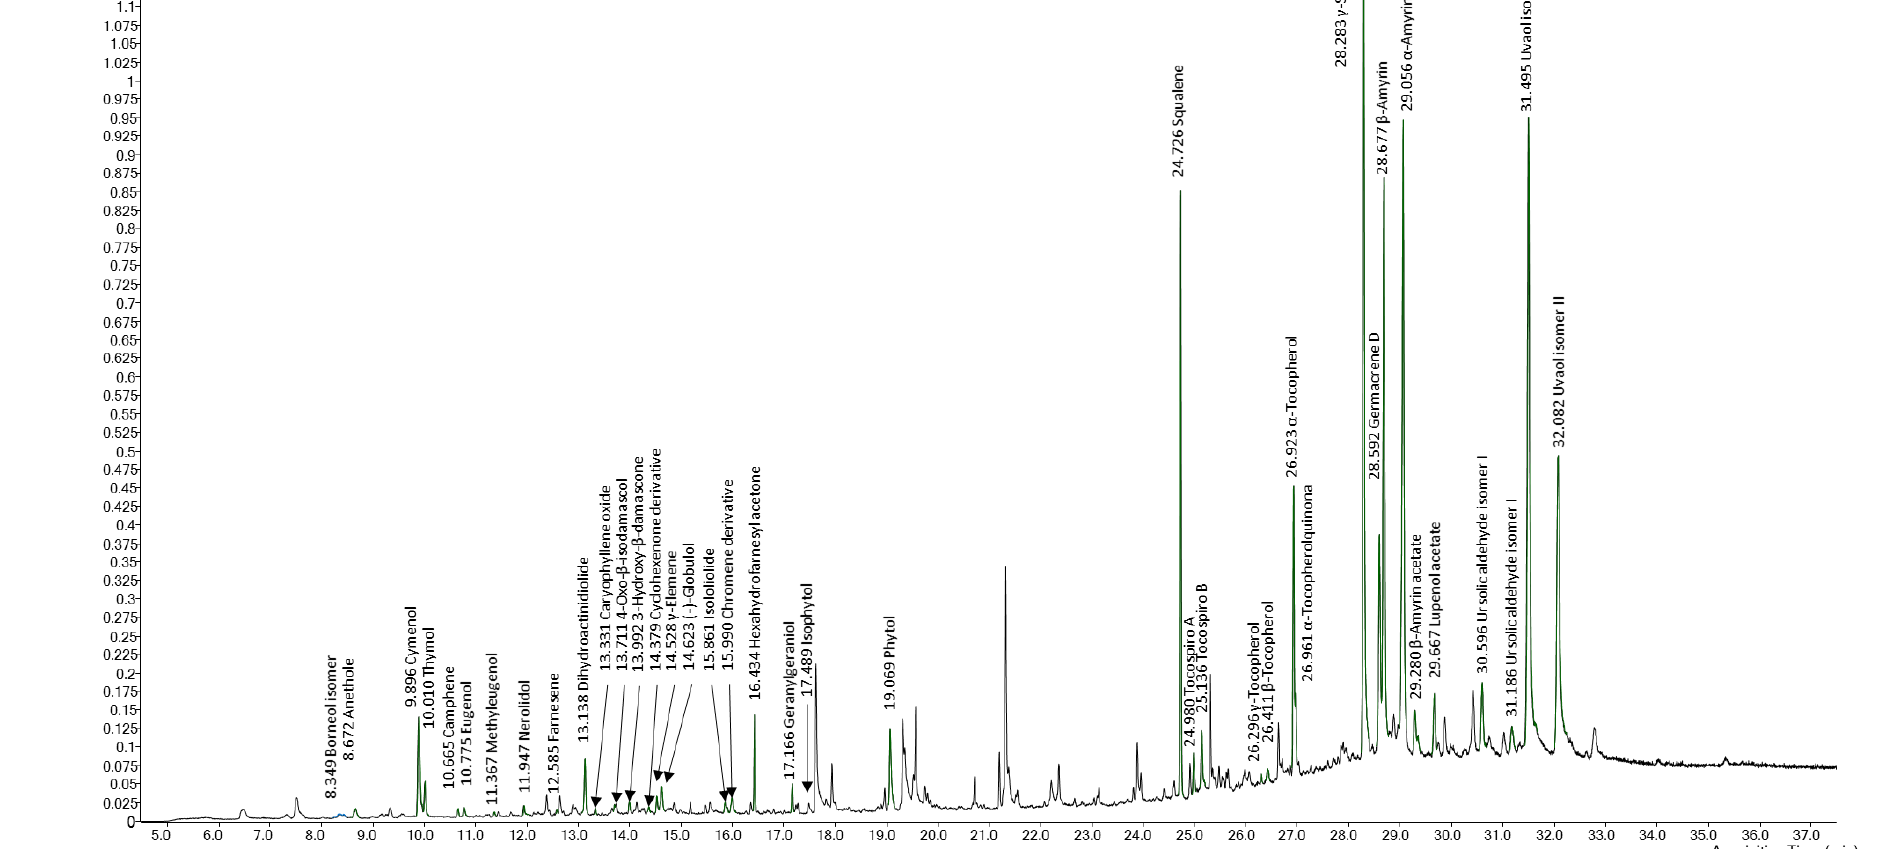
Figure 5. GC-q-TOF-MS total ion chromatogram of olive leave SFE extract obtained under control conditions (10 mg/mL). See peak assignment in Table 4. Non-terpenoid compounds identified: 1. n-Hexadecanoic acid; 2. Hexadecanoic acid; 3. cis,cis-7,10,-Hexadecadienal; 4. Octadecanoic acid; 5. 9-Octadecenamide, (z)-; 6. Cyclopropanebutanoic acid; 7. 9,12-Octadecadienoyl chloride, (z,z)-; 8. 6,9,12,15-Docosatetraenoic acid, methyl ester; 9. Myo-inositol.